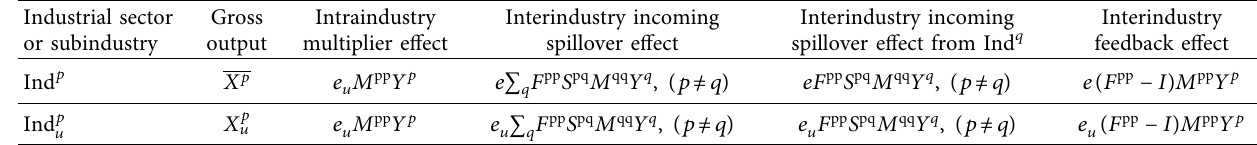
Table 1: Decomposition components of gross output in demand-driven and multisector input-output model.